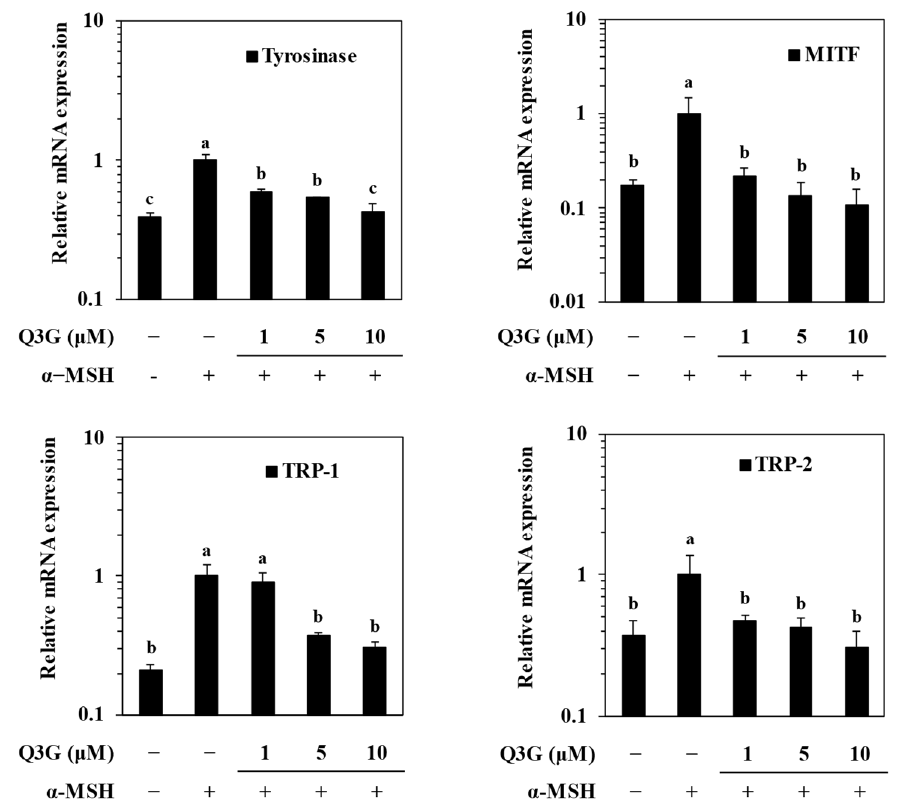
Figure 2. Effect of Q3G on mRNA expression levels of melanogenesis-related genes: tyrosinase, MITF, TRP-1, and TRP-2 in α -MSH-stimulated B16F10 melanoma cells. Stimulated cells were treated with or without Q3G for 24 h, and the mRNA levels were quantified with RT-qPCR. a–c groups with different superscript letters are significantly different, whereas same superscript letters mean no significant difference according to Duncan’s multiple range post-hoc test ( p < 0.05).